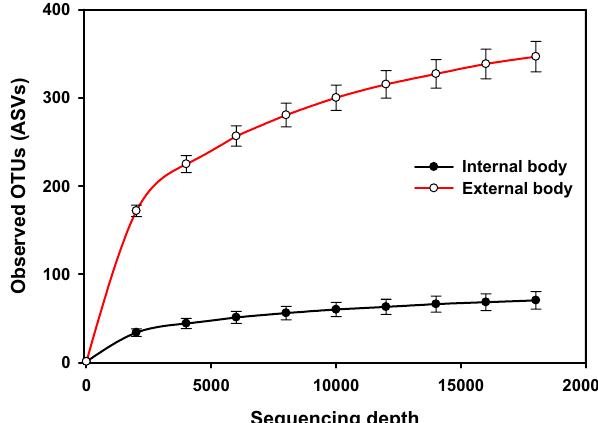
Figure 1. Rarefaction curves of the mean number of observed OTUs (sequence variants) in internal (endogenous) versus external body (exogenous) samples.